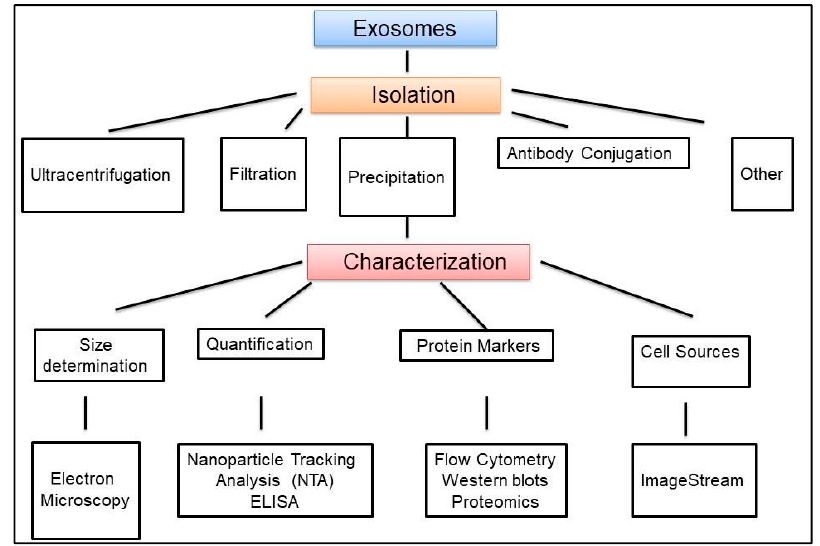
Figure 3. Exosome isolation and characterization general pipeline. Several methods are used for exosome isolation, and need to include validation and characterization of exosomes isolates.